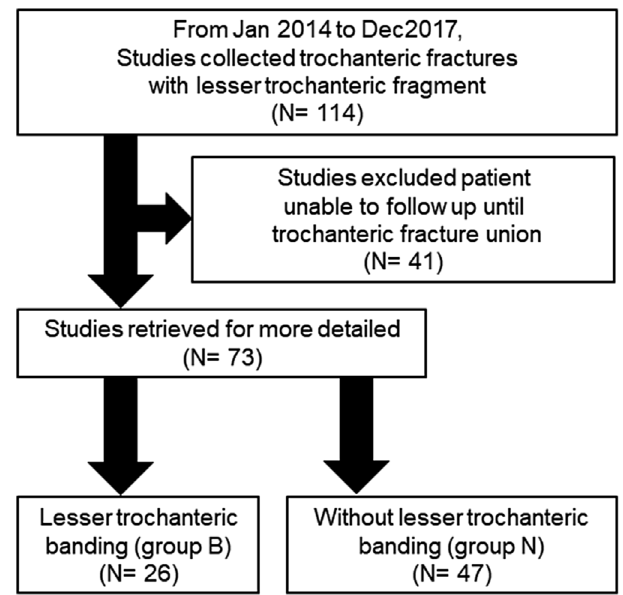
Figure 1. Flow diagram that describes the number of